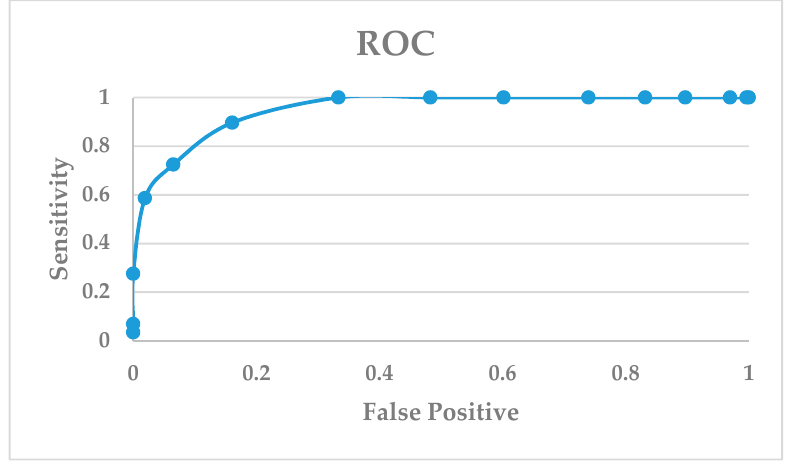
Figure 6. Docking enrichment plot of false positive vs. sensitivity in the 5NIU model.